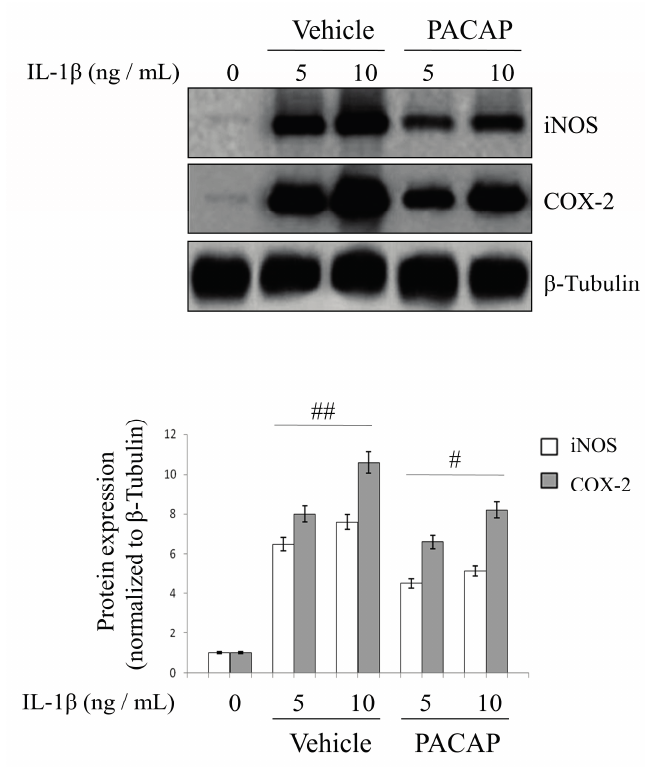
Figure 6. Effects of PACAP on IL-1 β induced iNOS and COX-2 expression levels. Chondrocytes were exposed to IL-1 β for 24 h at indicated concentrations and changes in iNOS and COX-2 protein levels were measured by Western blot analyses; Bands were quantified using ImageQuantTL software and normalized values were plotted in the histogram shown. Each value represents the mean band densities ± SEM from each group. ( # p < 0.05 or ## p < 0.01 vs. vehicle). Experiments were repeated at least three times with similar